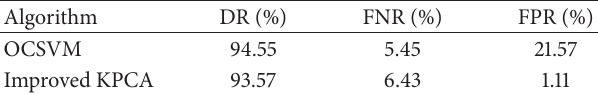
Figure 4: Elapsed time and speedup for 𝐾 -fold cross-validation. Table 3: Comparison of different